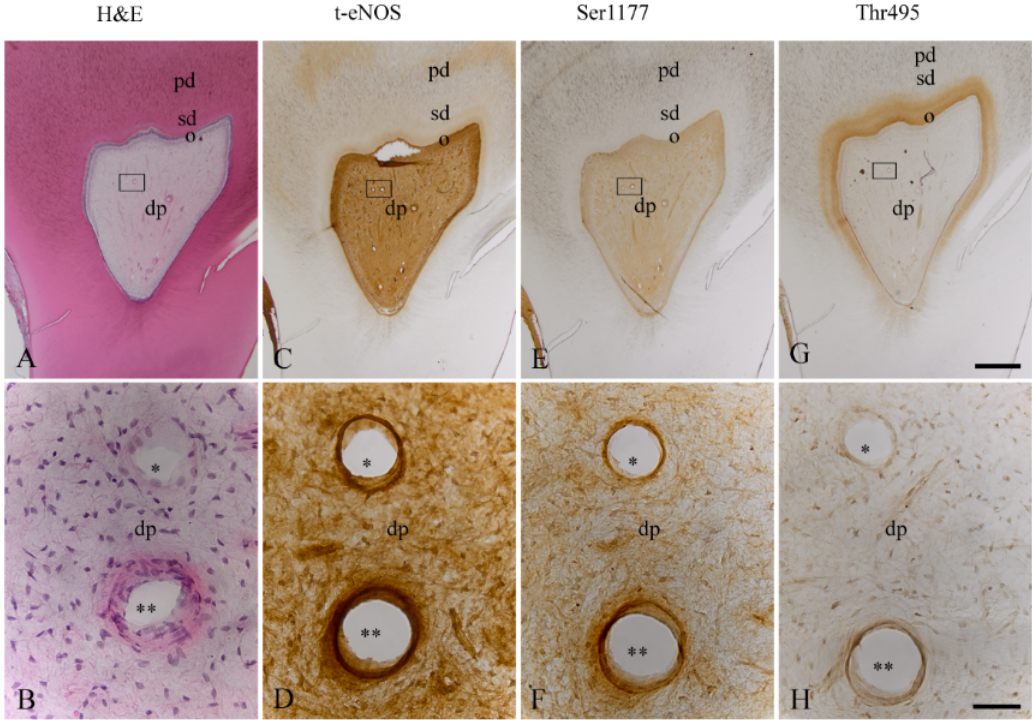
Figure 3. H&E staining and localization of t-eNOS, Ser1177, and Thr495 in blood vessels of the healthy dental pulp of a human third molar. In the overview image of a human third molar, the healthy dentin–pulp complex is found in a structural order with primary dentin, secondary dentin, the odontoblast layer, and the dental pulp without signs of inflammation ( A ). In the detailed image of the region drawn with a rectangle in A, the venous (one asterisk) and arterial (two asterisks) blood vessels and cells in the dental pulp are visible without signs of inflammation ( B ). In the same venous (asterisk) and arterial (two asterisks) blood vessels of the consecutive sections of the healthy dental pulp, eNOS ( C , D ) and Ser1177 ( E , F ) with stronger staining intensities and Thr495 ( G , H ) with weak staining intensity are detected. Odontoblasts show a homogenous localization for eNOS ( C ). Ser1177 ( E ) and Thr495 ( G ) are visible in both the same and different subpopulations of odontoblasts. In some subpopulations of human dental pulp cells, eNOS ( C , D ), Ser1177 ( E , F ), and Thr495 ( G , H ) are also identifiable at different staining intensities. Scale bars: ( A , C , E , G ) = 1 mm; ( B , D , F , H ) = 50 µ